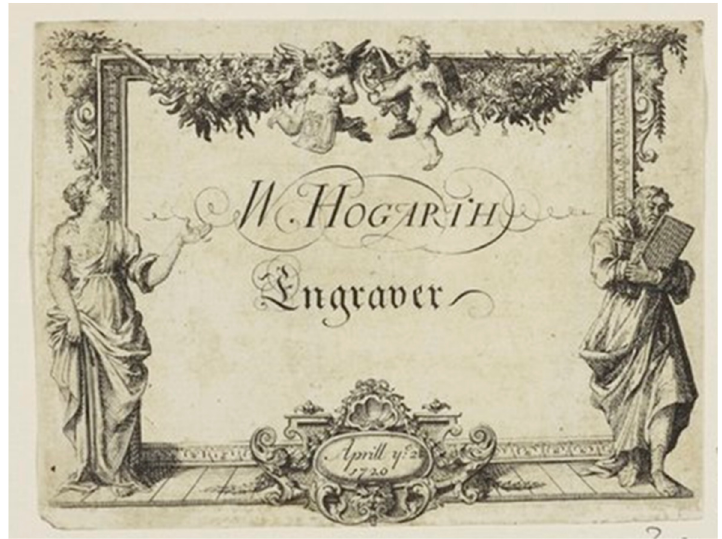
Figure 6. William Hogarth (England 1697–1764), Trade Card , 1720, Engraving, 7.7 cm × 10.2 cm, Royal Collection London.